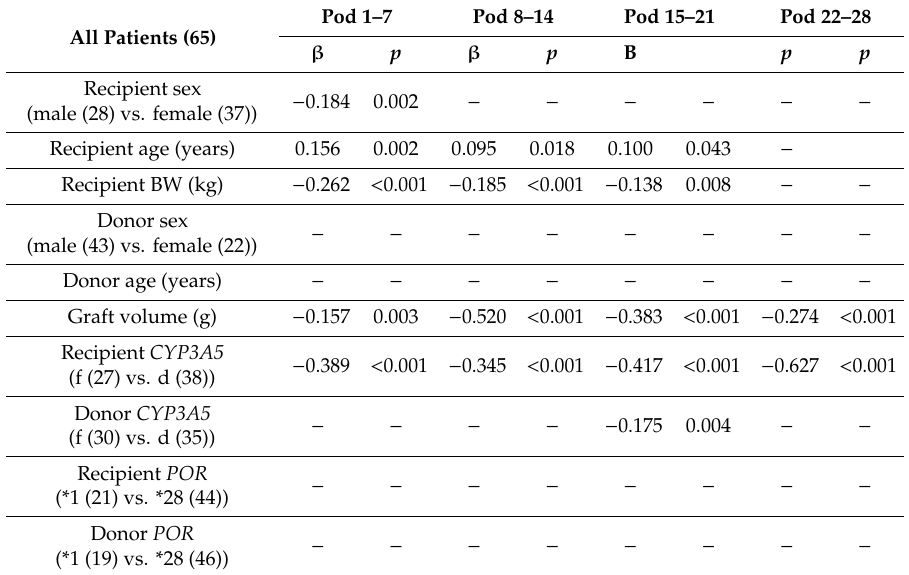
Table 4. Multiple regression analysis of all patients; (B) Multiple regression analysis of cases in which recipients had functional CYP3A5; ( C ).